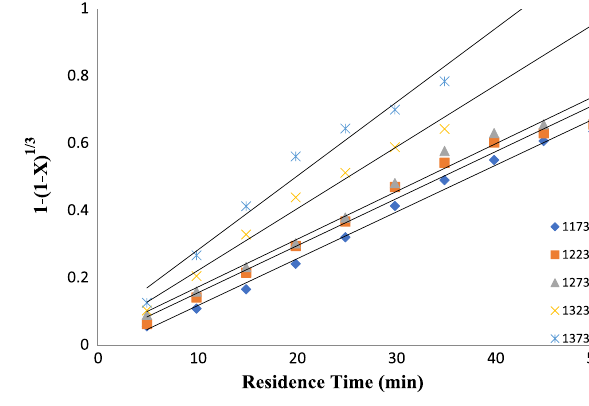
Fig. 5 Graph of 1 − (1 − X ) 1/3 versus residence time for LWVC-I